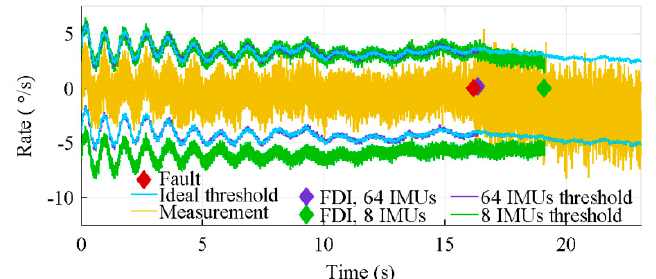
Figure 13. Typical 4𝜎 threshold of the centralized architecture with the algorithm considering sensors location, for 8 and 64 IMUs.